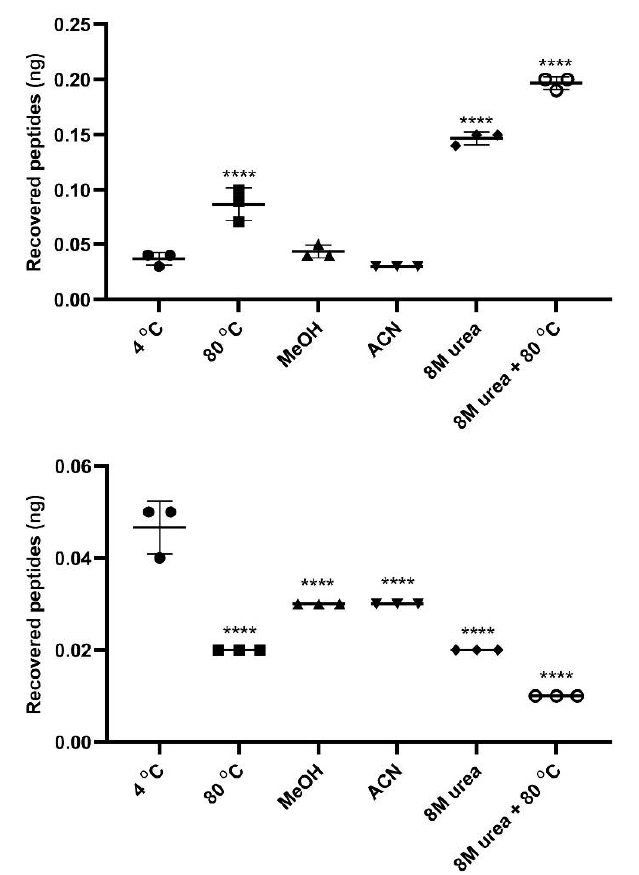
Figure 8. Quantitation of InPeps extracted from HEK293 cells in two independent rounds. Upper panel, first round of InPeps extraction: highest recoveries of InPeps were obtained in the flow- through of 10,000 Da size-exclusion membranes using cells homogenizing conditions that denature proteins and/or nucleic acids structures, such as water at 80 ◦ C (80 ◦ C), 8M urea in water (8 M urea), or 8M urea in water at 80 ◦ C (8 M urea + 80 ◦ C); note that, during this first round, the lowest amounts of InPeps were extracted with PBS at 4 ◦ C (4 ◦ C; smoothest extraction condition), methanol (MeOH), or acetonitrile (ACN) at room temperature. Bottom panel, second round of InPeps extraction: highest recoveries of InPeps were obtained directly from 10,000 Da size-exclusion membranes used to filter cells homogenized with PBS at 4 ◦ C during the first round of extractions, suggesting that extractions using smooth conditions can preserve InPeps associated to macromolecular (i.e., proteins and/or nucleic acids) components of the cells; note that, during the second round, the lowest amounts of InPeps were extracted from 10,000 Da size-exclusion membranes used to filter cells homogenized with either 80 ◦ C, 8 M urea, or 8 M urea + 80 ◦ C in the first round of extractions. Similar numbers of HEK293 cells were homogenized and used for all extractions experiments. InPeps quantification were conducted using fluorescamine. All experiments were performed in triplicate in three independent replicates, which produced similar results. Variations among triplicates were below 5%. MeOH: methanol. ACN: acetonitrile. **** p < 0.0001 relative to 4 ◦ C extractions. n = 3 independent determinations conducted in